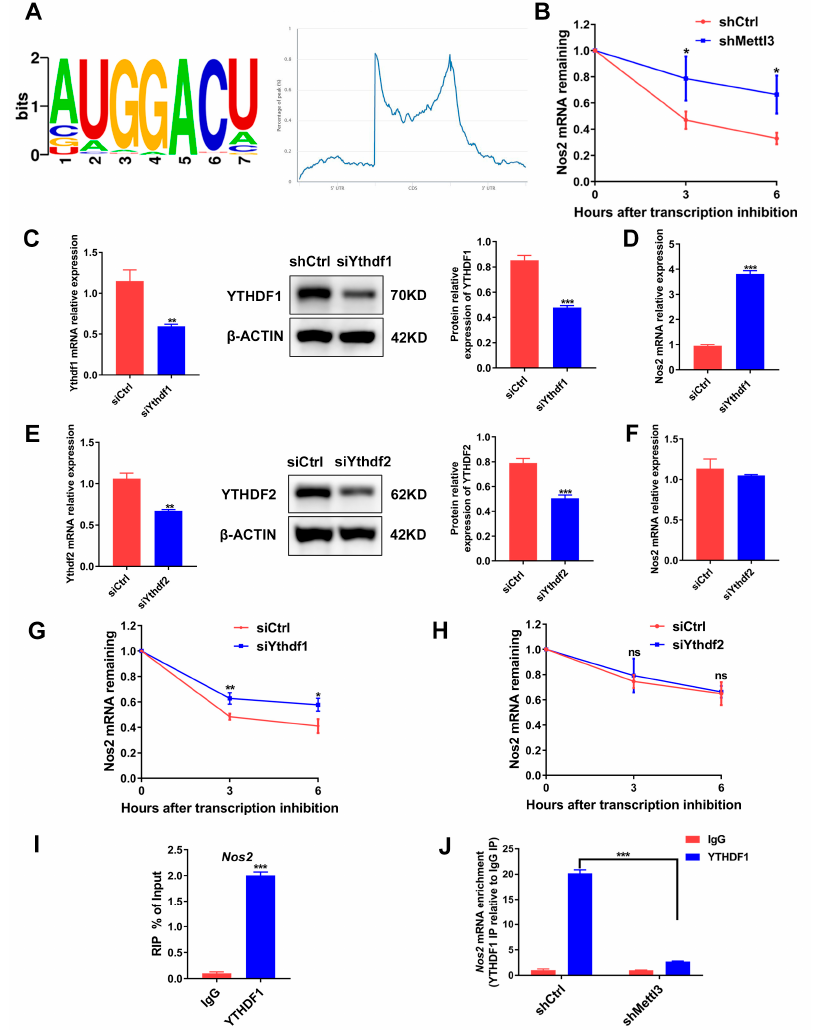
Figure 6. The role of METTL3, YTHDF1 and YTHDF2 in the degradation of Nos2 mRNA. ( A ) RMBase 2.0 database analysis of m 6 A motifs and m 6 A peak distribution on Nos2 transcript. ( B ) RAW264.7 cells transfected with shRNA were differentiated into osteoclasts. Then, cells were stimulated with actinomycin D (5 μ g/mL) to inhibit transcription. The Nos2 mRNA levels at the indicated time after actinomycin D treatment were assessed using qRT-PCR. (C–H) RAW264.7 cells transfected with siRNA were induced to differentiate into osteoclasts. ( C , E ) YTHDF1 and YTHDF2 protein levels were determined with Western blotting after siRNA-mediated gene knockdown. ( D , F ) Nos2 mRNA expression in the si Ythdf1 group or the si Ythdf2 group was measured with qRT-PCR. ( G , H ) Osteoclast precursors were treated with actinomycin D (5 μ g/mL) for the indicated time following inflammatory osteoclastogenesis. The mRNA expression of Nos2 was determined using qRT-PCR. Cells transfected with the negative control siRNA acted as the control group. ( I , J ) A RIP-qPCR assay using an IgG antibody and an anti-YTHDF1 antibody was performed to determine the binding of Nos2 mRNA with YTHDF1. β -Actin was used as an internal control for qRT-PCR and Western blotting. The data are shown as the mean ± SD ( n = 3). ns, no significance; * p < 0.05; ** p < 0.01; *** p < 0.001.